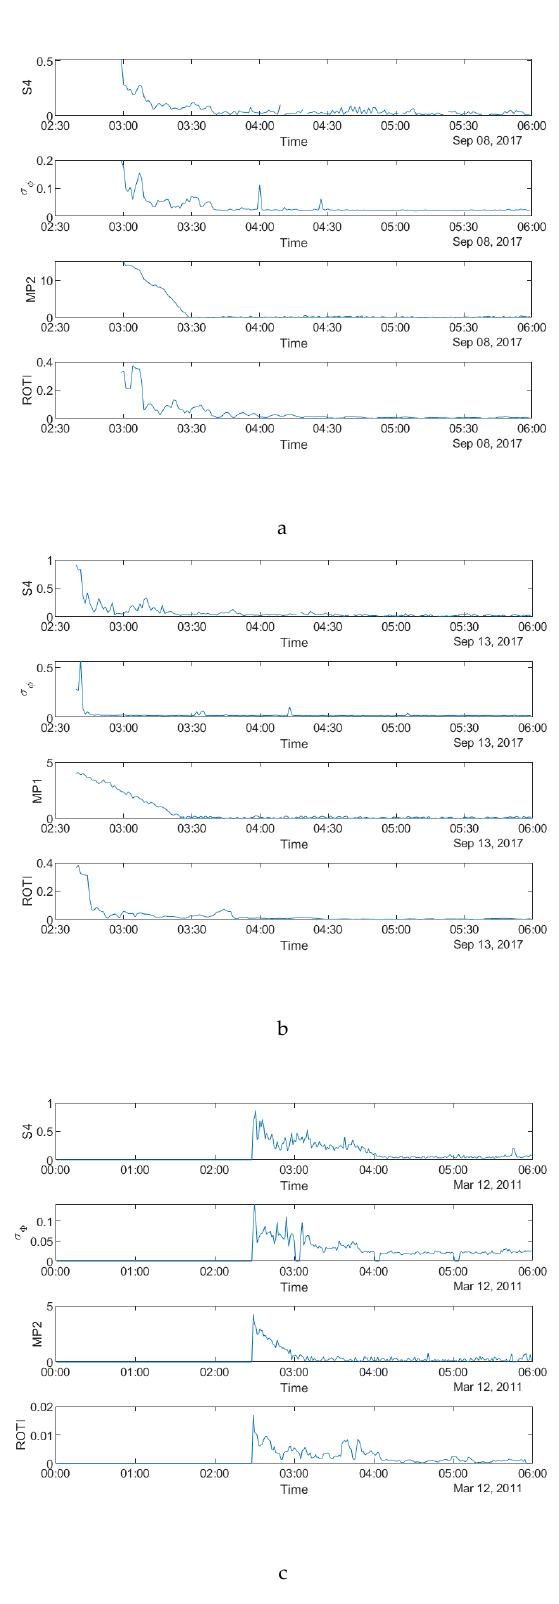
Figure 4. xxxxx Figure 4. Time series plots of four parameters: ( a ) during 00:00:00-06:00:00 UTC on 8 September